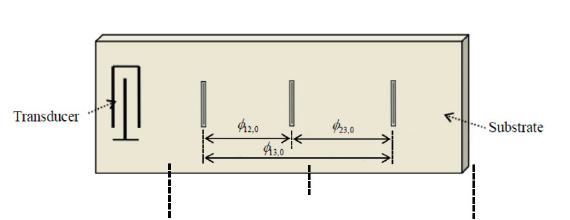
Figure 1. Structure of the delay-line sensor with three